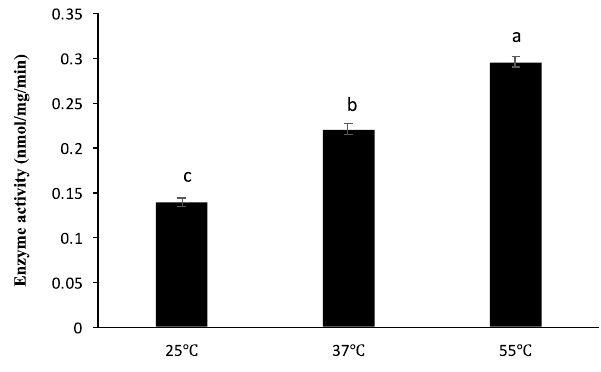
Figure 2. Dephosphorylation of PA FLA by sweet potato PAP in dif- ferent temperatures. The phosphatase assay was performed in a 1-mL reaction mixture containing 4 μL of the enzyme (46.4 μg) and 1 μg of PA FLA substrate at pH 5.5 (Na-acetate) for 4 hours at 25°C, 37°C, and 55°C. Enzyme activity was defined as the amount of en - zyme required to liberate 1 nmol of inorganic phosphate per min di- vided by mg of the protein. The data were expressed as the mean and standard errors from three experiments. PA FLA, Pseudomonas aeruginosa flagellin; PAP, purple acid phosphatase. a-c Means lacking common letters differ significantly